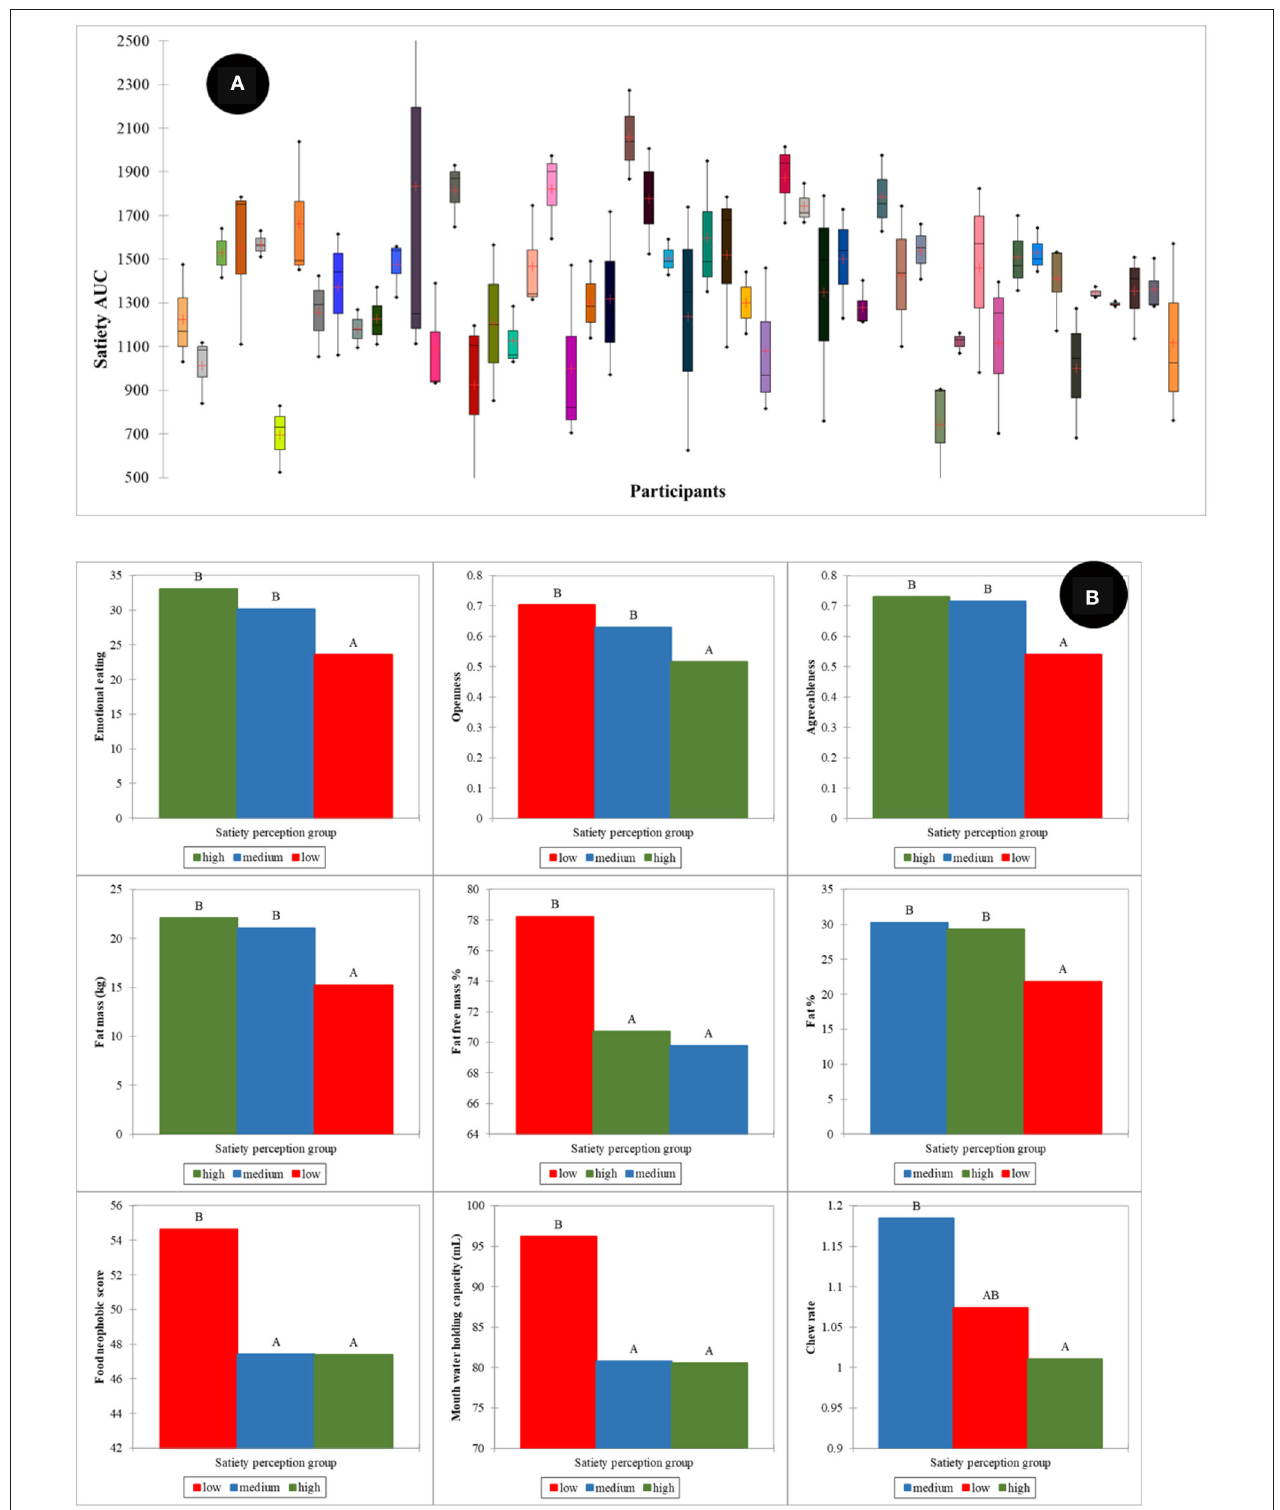
FIGURE 8 | Individual variation in satiety perception (A) , human factors differences between satiety perception phenotype groups (B) . Low, intermediate, and high satiety categories were defined as those individuals that perceive high (1,500–2,500 AUC), intermediate (1,000–1,500 AUC), and low (400–1,000 AUC) satiety, respectively. Where the mean difference between groups is significant at the 0.05 level they are labeled with different letters. The results are summarized from all food types.